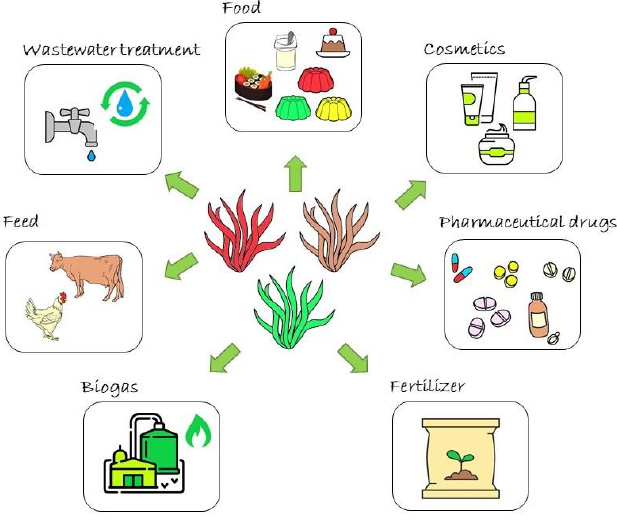
Figure 1. Human uses of